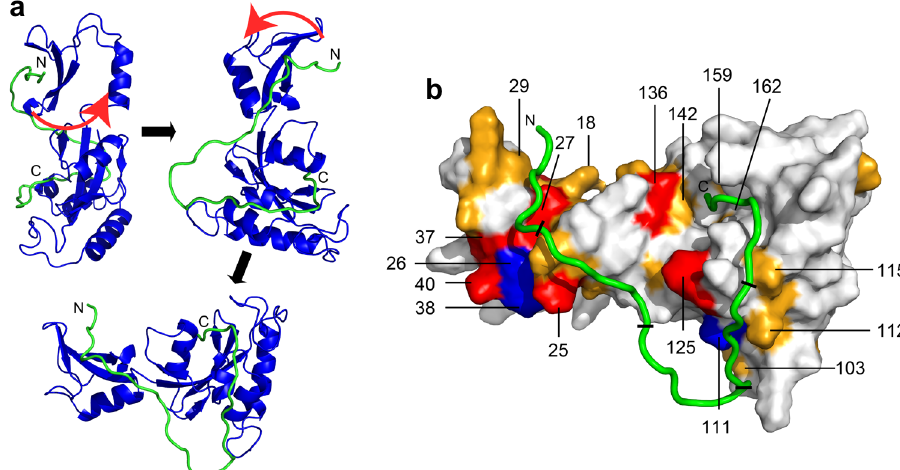
Fig. 7 Model of Ess1 binding to a 5R-CTD peptide. a This panel shows the orientation of Ess1 in this fi gure relative to that in Fig. 1a. The structure of Ess1 is from Fig. 1a, and the peptide model is from Fig. 6c. The N- and C-termini of the peptides are marked as shown. b CSPs are mapped onto the space- fi lling structure of Ess1, and color-coded orange and red for CSPs > 0.03 ppm and CSPs > 0.1 ppm, respectively. Residues highlighted in blue are those amide resonances that were broadened beyond detection. The black slash marks demarcate the fi ve individual CTD heptad repeat units. Note the C-terminal portion of the peptide containing the pSer-Pro motif lies deep in the active site. The residues N-terminal to the peptidyl – prolyl bond in the active site would be able to rotate 180° as suggested by NMR studies with Pin1 (see text and Supplementary Movie